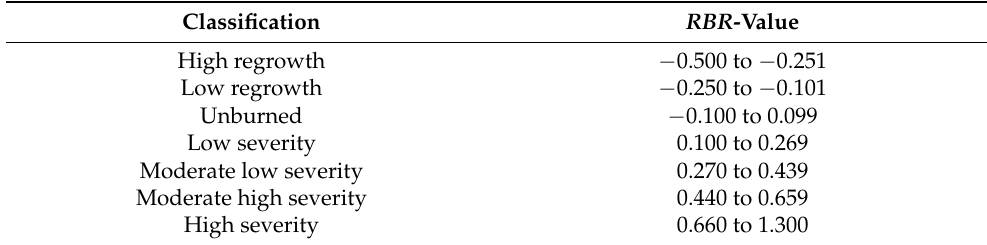
Table 2. Classification of the fire severity from the Relativized Burn Ratio according to United States Geological Survey—USGS [35].